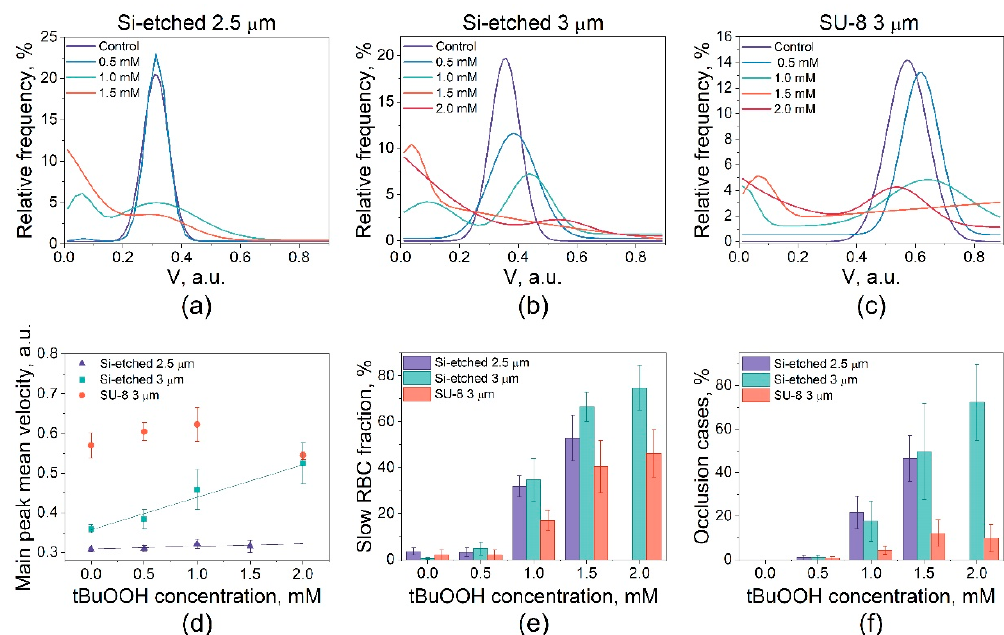
Figure 2. RBCs transport in microfluidic channels: ( a ) total view of occluded 1.5 µm wide channels by RBCs, treated with 0.5 mM of tBuOOH (* mark the damaged channels); ( b ) example of a 3 µm wide microchannel made by SU-8 mold (the marks indicate recognition points for the script to determine RBCs velocities); ( c ) example of a 3 µm wide microchannel made by Si-etched mold. All images were obtained by a brightfield optical microscope.